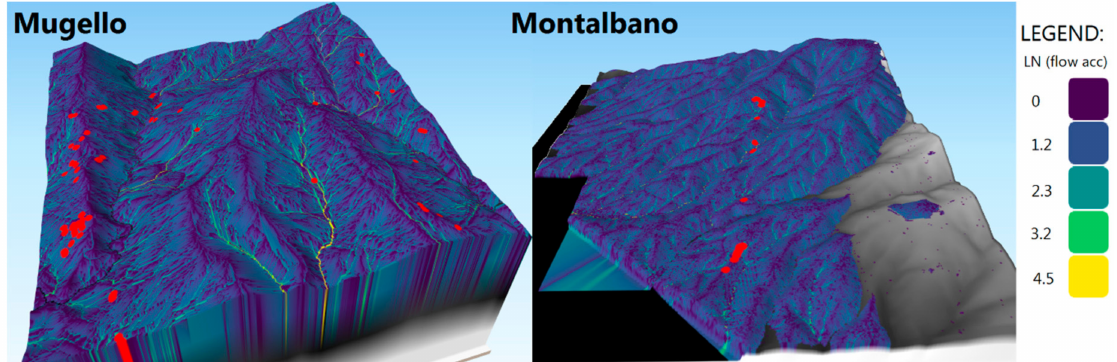
Figure 4. 3D representation of the flow accumulation map of the two study areas (Scale: Mugello 1:10,000; Montalbano 1:25,000). The survey points are shown in red. The color coding shows the amount of overland flow that traverses each cell (1 × 1